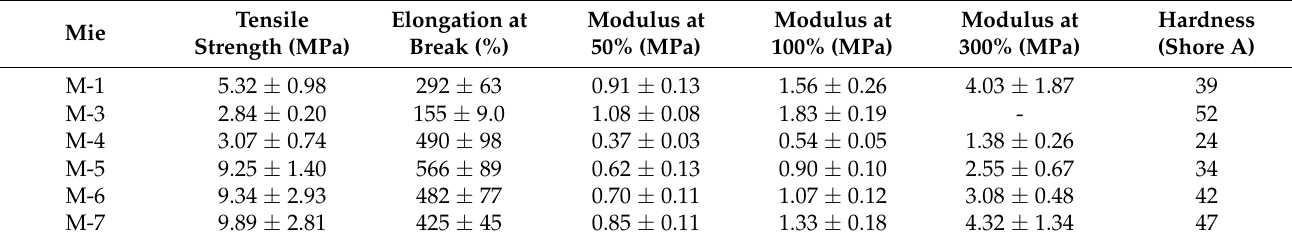
Table 4. Tensile properties and hardness of the